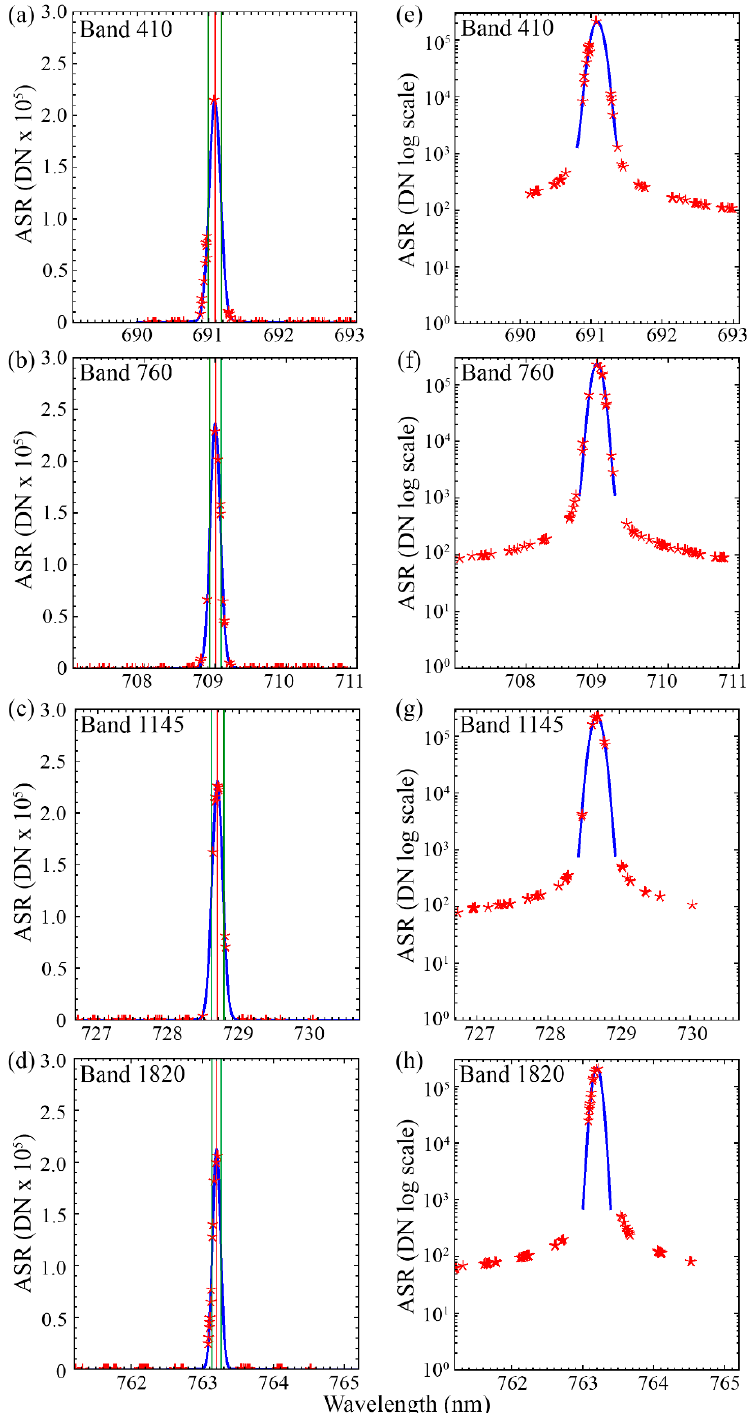
Figure 4. Examples of absolute spectral response (ASR) functions for several FIREFLY bands. The actual observations (red stars) are interpolated with a Gaussian function (blue line) to calculate the full-width at half maximum (FWHM) (green lines) for the band center (red line). The full observations are shown in panels (a) – (d) for the band numbers stated in the panels. The fit of the function to the peak of the observations for the same bands are shown in panels (e) – (h).